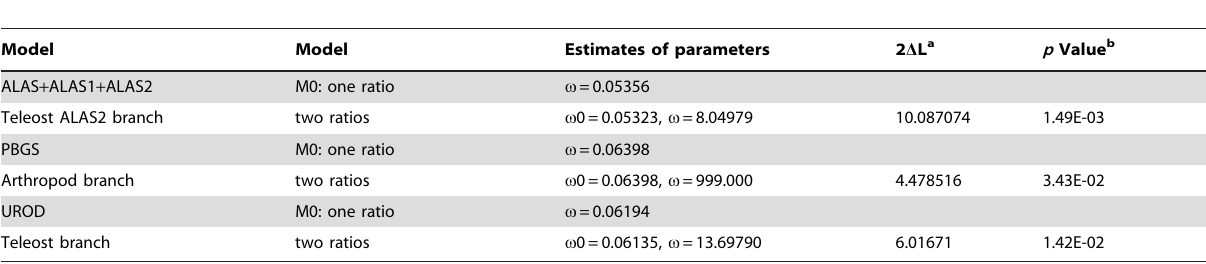
Table 2. Selection pressure of genes of heme-biosynthesis pathway by employing the branch model.